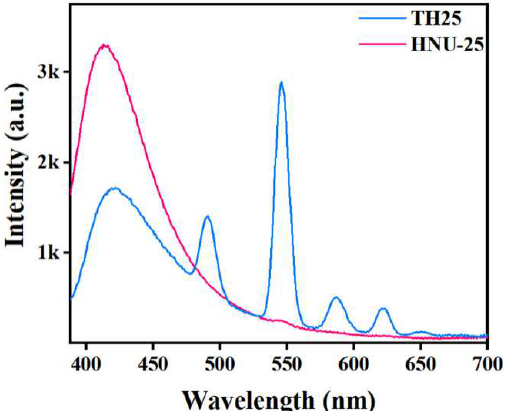
Figure 3. Solid-state fluorescence spectra of HNU-25 and TH25 ( λ ex = 365 nm). According to the reported literature, we found that organic acids and bases can affect the binding of carboxylate groups to Ln 3+ ions [47,48]. On this basis, a ratiometric fluores- cence probe for a specific organic acid based on TH25 was developed. To investigate the sensing performance of TH25 for organic acids, the suspension of TH25 was added to a DMF solution containing different organic acids (FA, lactic acid (LA), citric acid (CA), ace- tic acid (AA), and oleic acid (OA)), and the fluorescence spectra were measured after mix- ing for 30 s. As shown in Figure 4a, the fluorescence intensity of TH25 at 414 nm remark- ably improves with the addition of other organic acids except for OA, while the fluores- cence intensity at 545 nm is significantly decreased. The addition of OA results in a de- creasing trend of fluorescence intensity at both 414 nm and 545 nm. Meanwhile, the I 414 /I 545 values of TH25 in the different organic acids can be used to represent its sensing perfor- mance. Figure 4b shows that the value of I 414 /I 545 changes most significantly after the ad- dition of FA, indicating that TH25 has the highest selectivity and sensitivity to FA. ( a ) ( b ) Figure 4. ( a ) Fluorescence spectra of TH25 with the addition of different organic acids ( λ ex = 365 nm); ( b ) Fluorescence ratio of emission intensity at 414 nm and 545 nm in TH25 upon addition of different organic acids. The rapid response of TH25 to FA led us to further explore its detection sensitivity. TH25 was added to different concentrations of an FA solution and stabilized for 30 s be- fore testing its fluorescence spectrum. As shown in Figure 5a, when FA concentration was gradually increased to 750 ppm, the fluorescence intensity at 414 nm gradually increased,